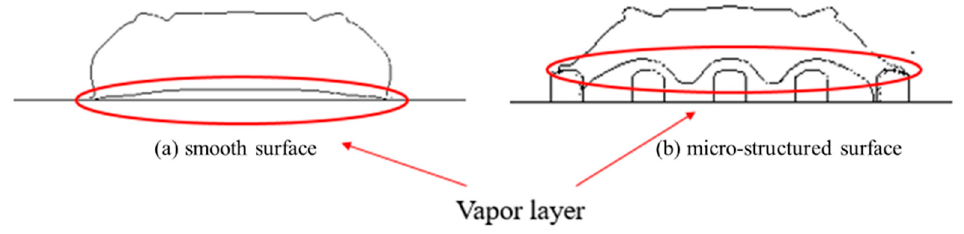
Figure 16. Leidenfrost behavior on smooth and micro-structured surface.